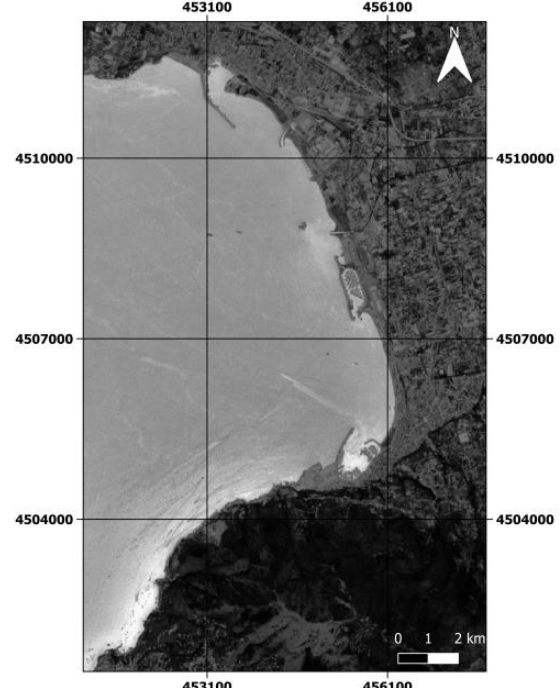
Figure 3. NDWI obtained from the Sentinel-2A images in UTM/WGS 84 plane coordinates (EPSG: